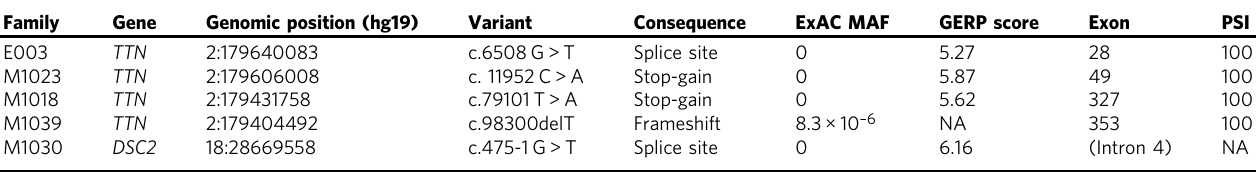
Table 2 AF-associated loss-of-function variants in AF families Family